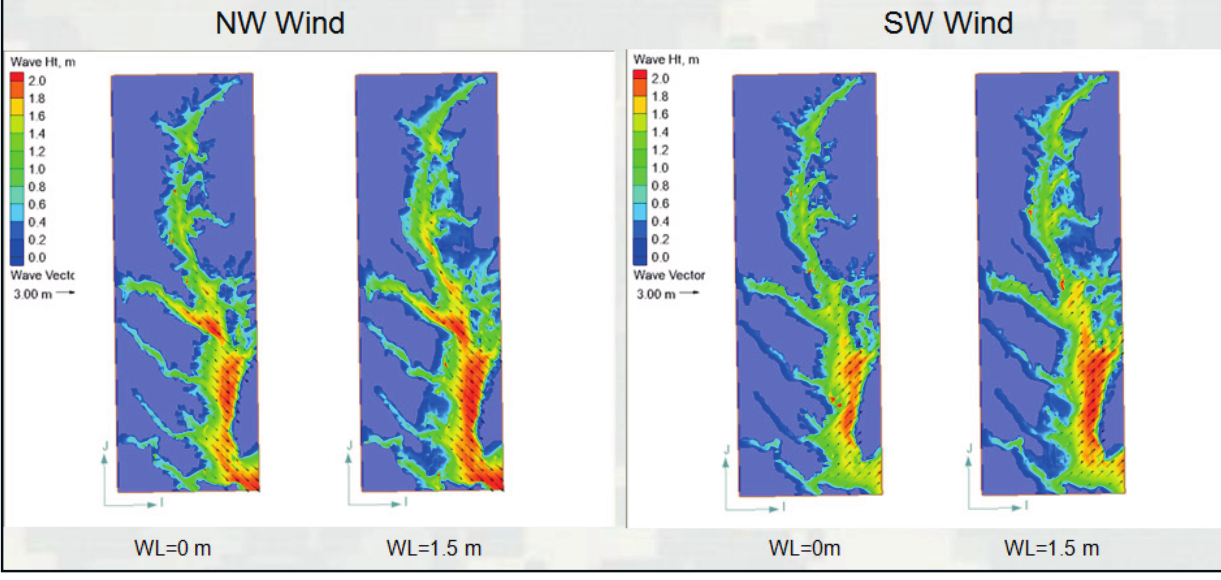
Figure 12. Calculated wave heights in Chesapeake Bay at two water levels (50-year design winds from NW and SW